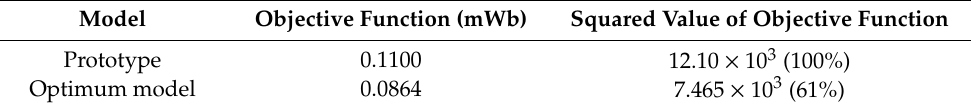
Table 5. Comparison of objective function and its squared value.